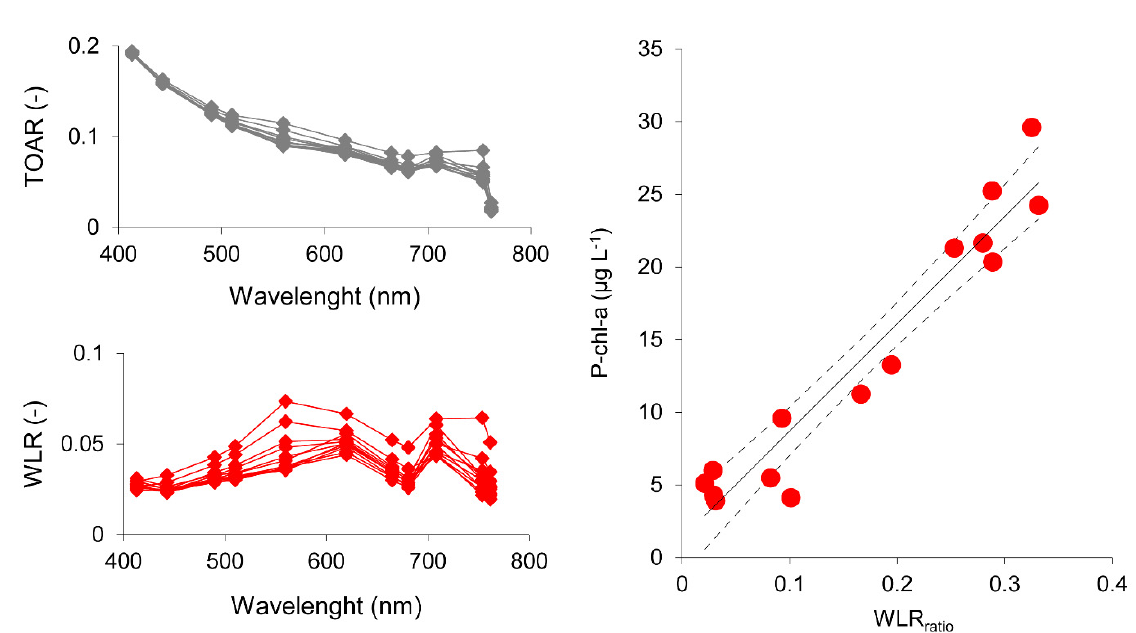
Figure 5. Left panels: spectral signatures of nine Lake Occhito sampling stations (St2, St3, St4, St5, St7, St8, St9, St10, and St11), before (upper panel) and after (lower panel) the atmospheric correction; TOA = Top Of Atmosphere Reflectance, WLR = Water Leaving Reflectance. Right panel: linear regression (solid line) between WLR ratio computed with Equation (1) and the P. rubescens chlorophyll-a (P-chl-a) concentrations measured in the field through multiple stations fluorometric profiles in the corresponding sampling stations. Dashed lines represent the 95% confidence interval, P-chl-a: 3–29 µg L − 1 .